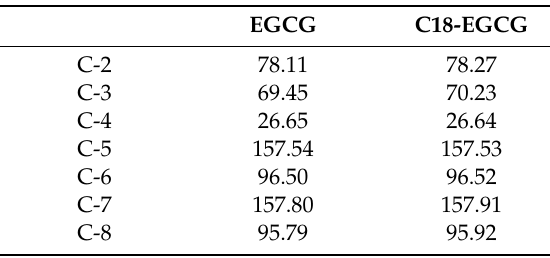
Table 2. 13 C NMR Chemical Shifts a .